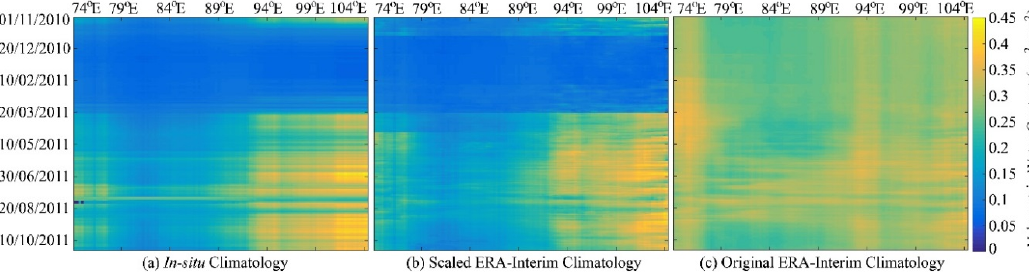
Figure 4. Time-longitude diagram for SM products: ( a ) in situ climatology; ( b ) scaled ERA-Interim climatology, and ( c ) original ERA-Interim climatology, for the calibration period (1 November 2010–31 October 2011).